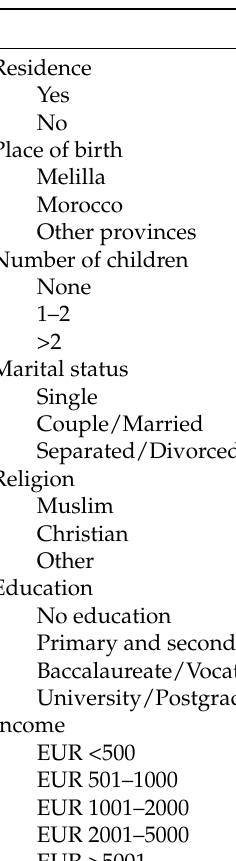
Table 1. Features of study sample (N =